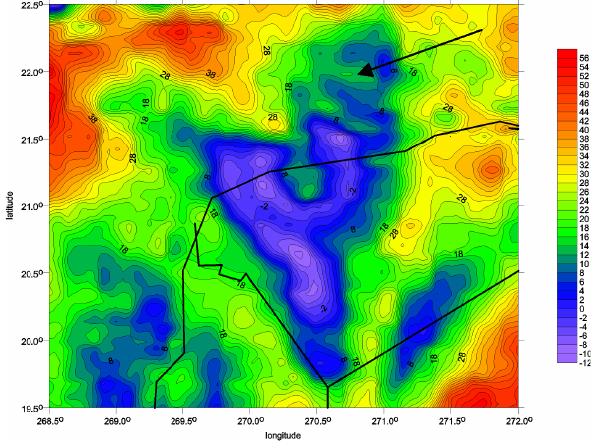
Fig. 5. Second derivatives T rr based on the complete EGM2008 at Chixculub [E]. To be compared also with Fig. 4 in Espindola et al.